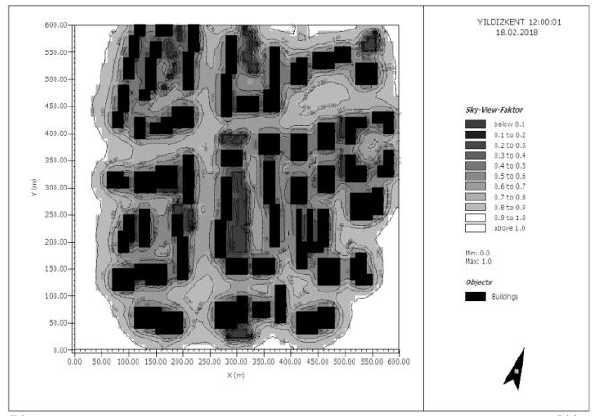
Figure 9. The Sky View Factor distribution for Mahallebasi, by ENVI-met v4.1